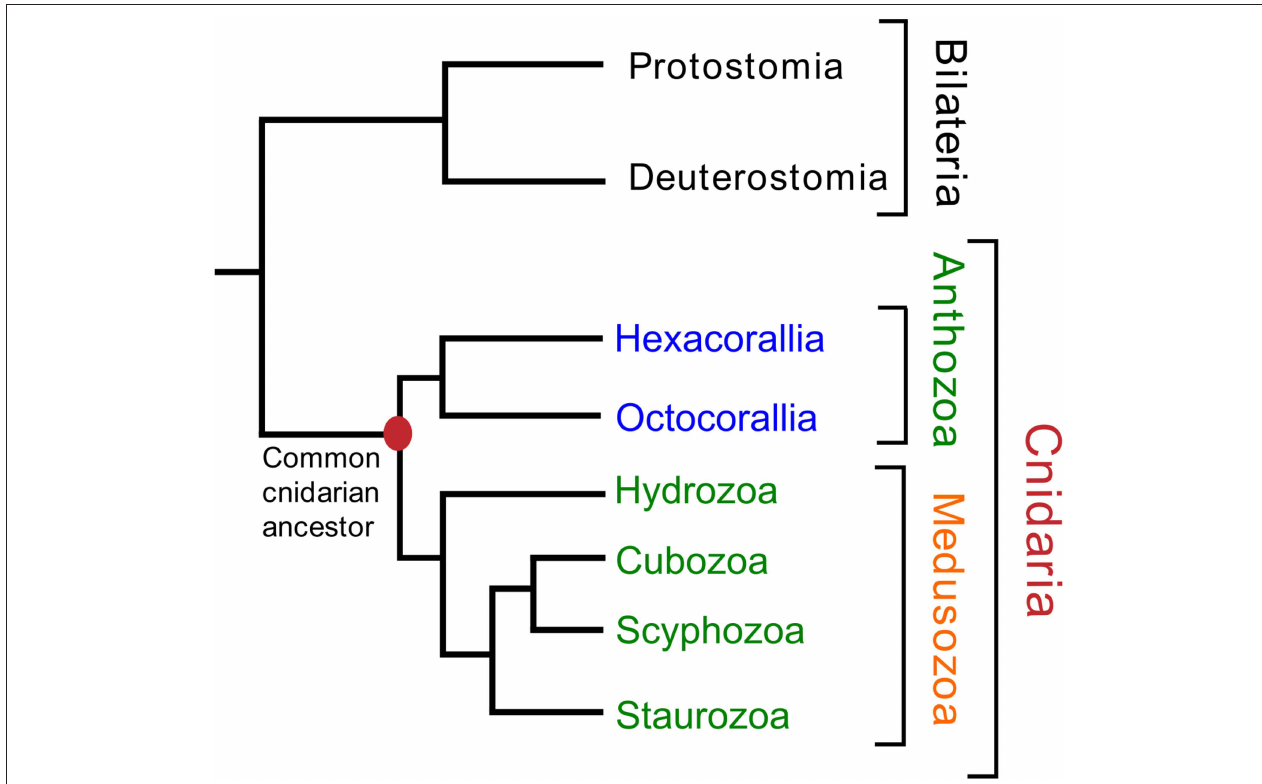
FIGURE 1 | Phylogenetic relationships of the various cnidarian classes and subclasses. The class Myxozoa has been omitted in this figure, because of its uncertain position. Names highlighted in red indicate(s) a phylum (Cnidaria); in orange, a subphylum (Medusozoa); in green, a class; in blue, a subclass. The classes Staurozoa, Cubozoa, Scyphozoa, and Hydrozoa are often collected in the subphylum Medusozoa. The class Anthozoa can be subdivided into the subclasses Hexacorallia and Octocorallia. This figure is based on data from Technau and Steele (9), Zapata et al. (10), and Kayal et al.